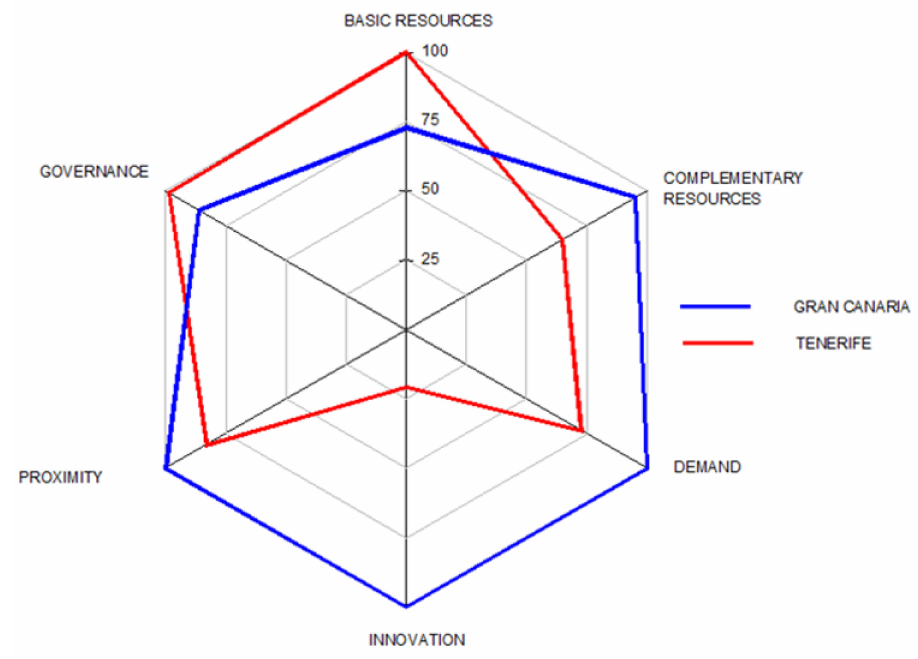
Figure 6. A comparative graph of resources and capabilities for Gran Canaria and Tenerife. Table 4. Resources and capabilities assessment in Gran Canaria and Tenerife.